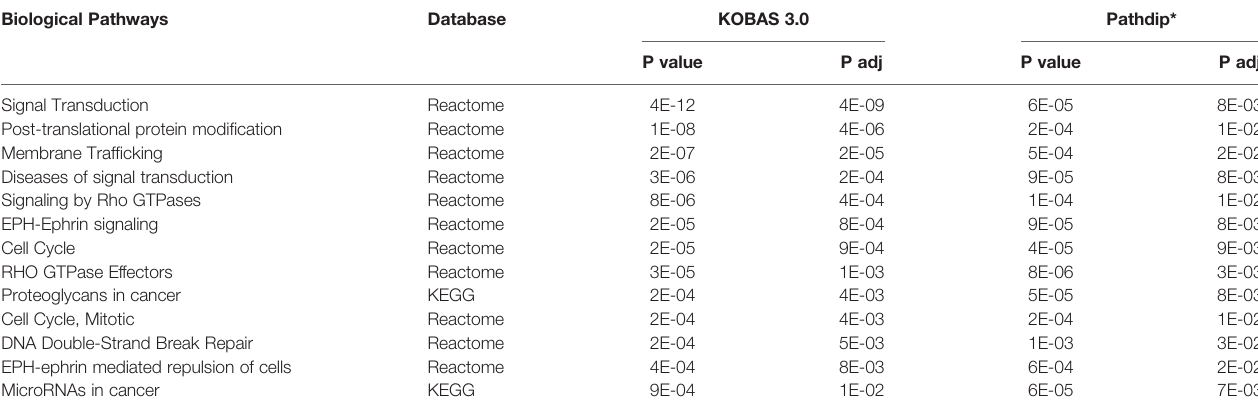
TABLE 2 | Biological pathways enriched (P value < 0.001 and P adjusted < 0.05) by the genes detected in the miRNA-mRNA integrative analysis (KOBAS 3.0 and Pathdip in silico pathway tools). Biological Pathways